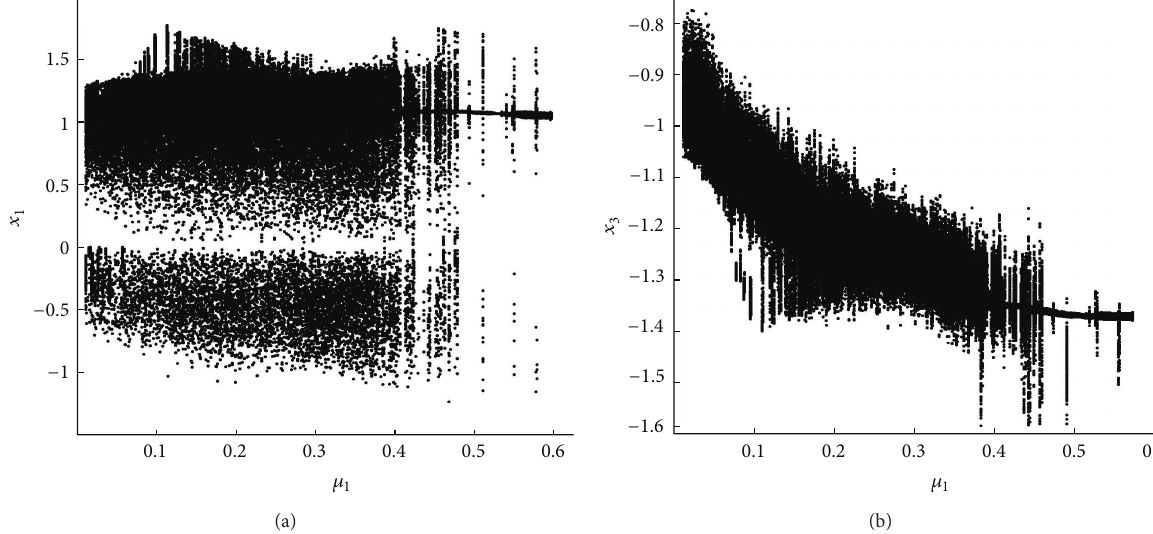
Figure 6: The bifurcation diagram is obtained for the damping coefficients 𝜇 1 = 0.06 ∼ 0.6 and 𝑓 2 = 55.1 ; (a) the bifurcation diagram on the plane (𝑥 1 ,𝜇 1 ) ; (b) the bifurcation diagram on the plane (𝑥 3 , 𝜇 1 )